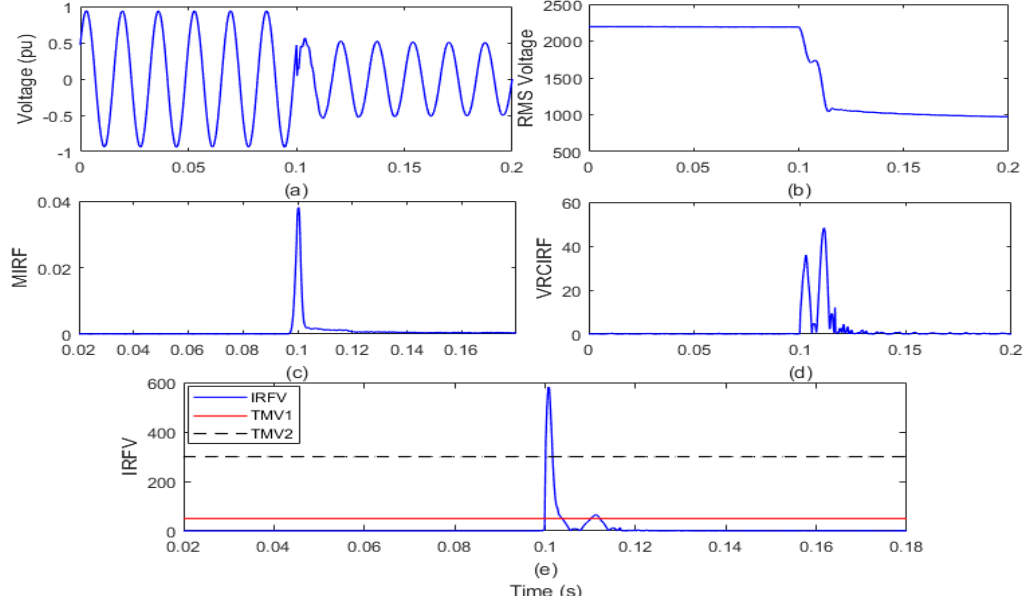
Figure 8. Two-phase fault ( a ) voltage signal ( b ) root means square value of voltage ( c ) median-based IRF ( d ) rate of change in voltage-based IRF ( e ) islanding recognition factor based on voltage.